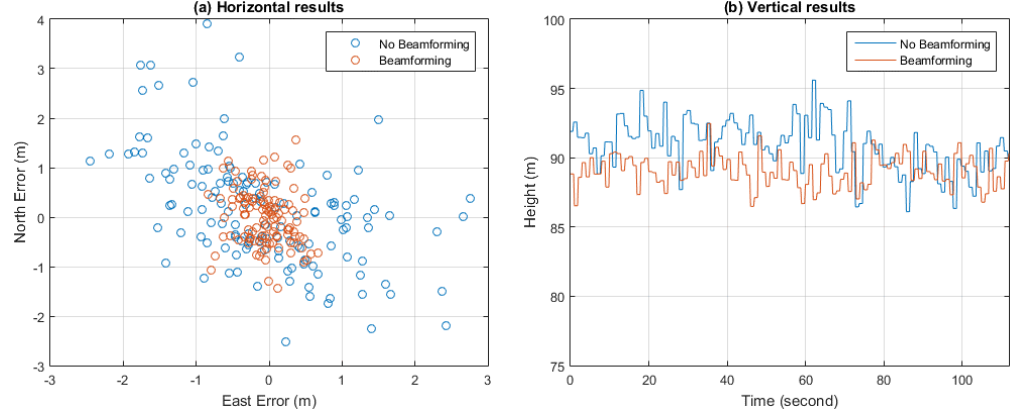
Figure 23. Results of C/N0 with beamforming (solid lines) and without beamforming (dotted lines).